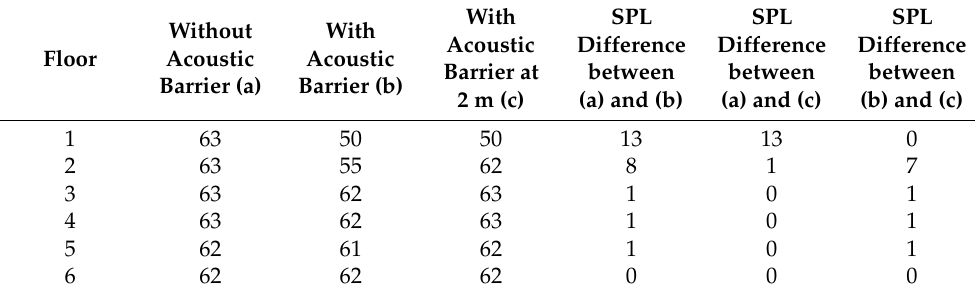
Table 7. Numerical change of SPL for each layer after adding an acoustic barrier (Unit: dB(A)).